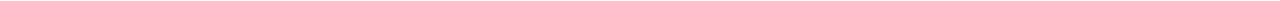
Fig. 2 Neuronal inactivation of PKD in mouse and human ischemic brain. a – c Wild-type mice were sham-operated or subjected to 60 min of MCAO and killed 24 h after reperfusion. ( a , left panels) Representative images of coronal brain sections stained with Nissl are shown. The ischemic core in the striatum (S) and in the adjacent cortex (C) corresponding to the penumbra area and the equivalent areas in sham-operated animal are depicted. b , c Representative confocal microscopy images showing predominant localization of p-PKD(S916) staining in NeuN+ cells in brain from sham-operated animals, the absence of active kinase, and NeuN staining at the striatum ( b ) or the decrease in p-PKD(S916) signal on NeuN+ cells at the cortical penumbra area in ischemic brain ( c , left panels). ( c , right panel) Percentage of NeuN+ cells containing p-PKD(S916) staining in penumbra zone of MCAO-operated mice compared to the equivalent cortical region of sham-operated animals ( n = 100 neurons; n = 3 sections per animal, n = 3 animals per condition). d Decreased number of neurons with p-PKD(S916) staining in postmortem human ischemic stroke samples compared to that from control subjects. Representative confocal microscopy images showing predominant localization of p-PKD(S916) staining in NeuN+ cells in samples C-1 and S-2 are shown (Supplementary Table 1). (Right panel) Percentage of neurons bearing active p-PKD ( n = 30 – 50 neurons per section; n = 3 individuals per condition). c , d Zoom images from boxed regions are also shown. For quanti fi cations, mean ± s.e.m. were derived from the indicated number of samples and analyzed with two-tailed unpaired Student's t test. *** P <